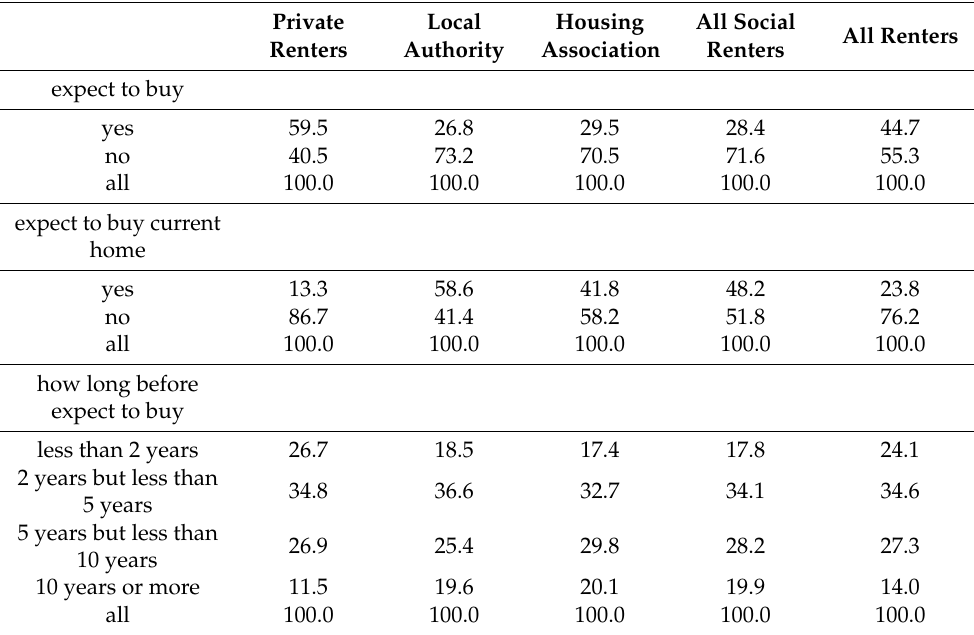
Table A14. Buying expectations, social and private renters, 2019–2020